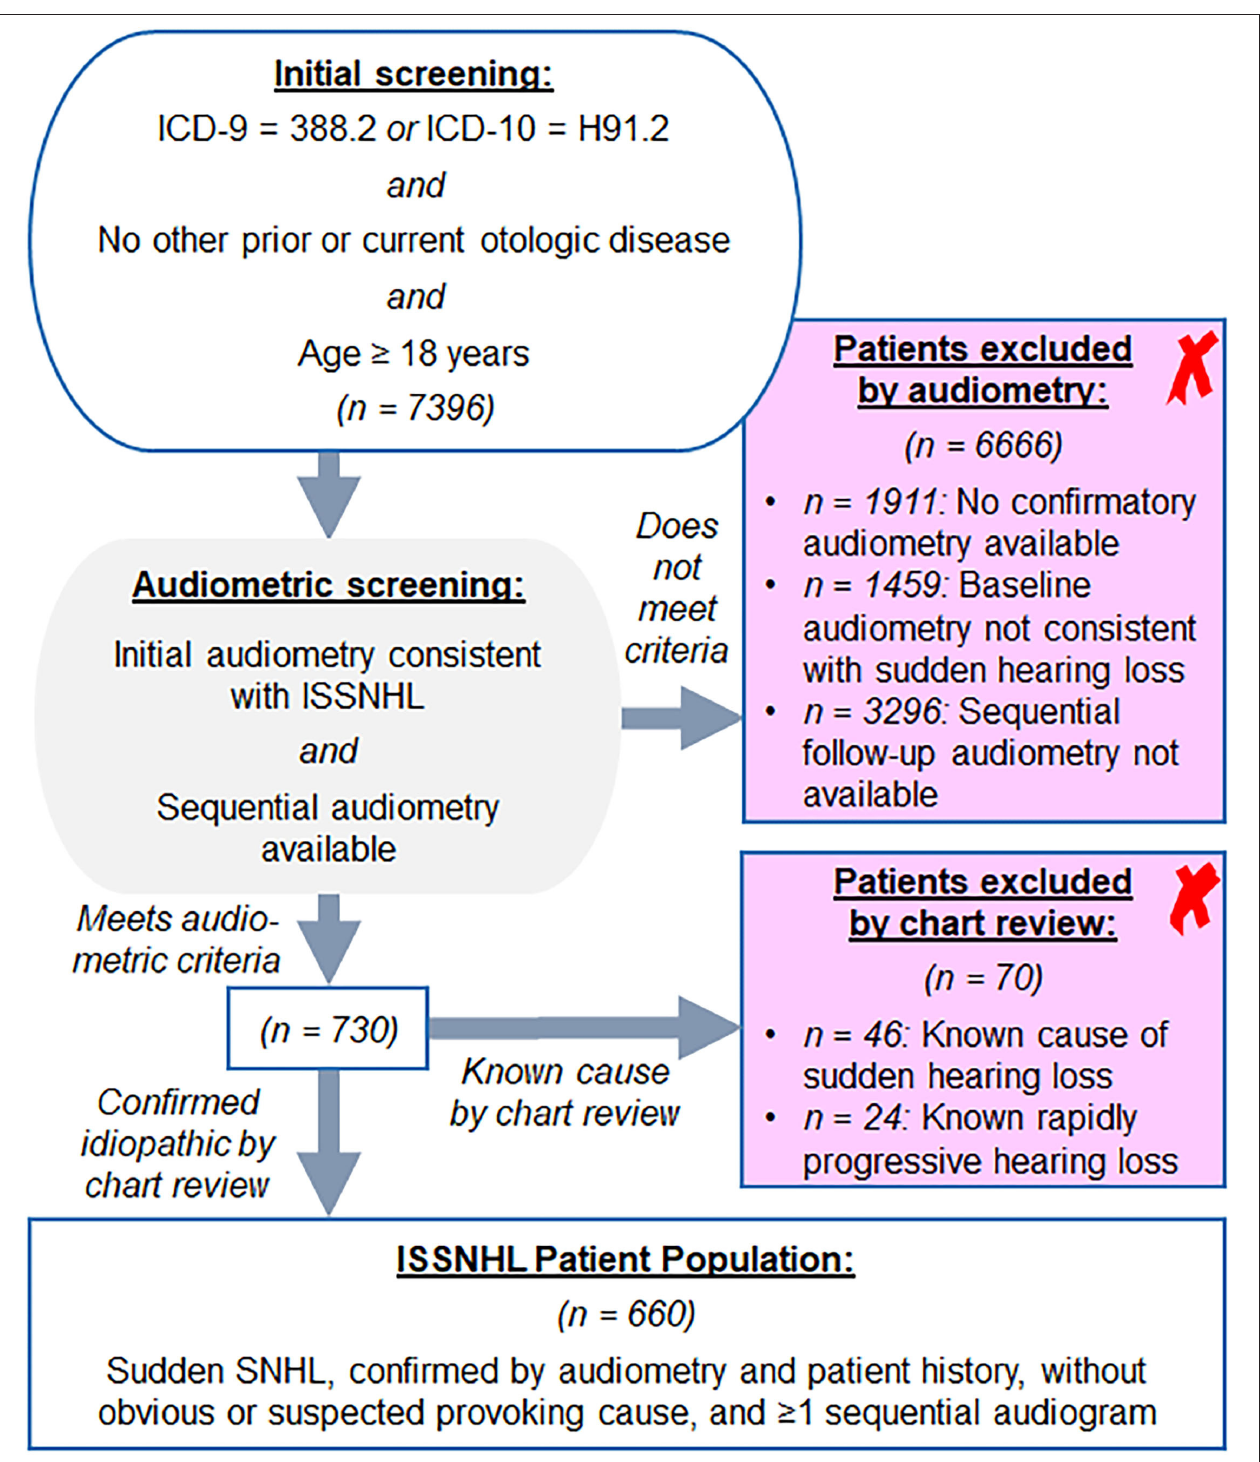
FIGURE 1 | Screening approach from Mass Eye and Ear audiology database for the patients with idiopathic sudden sensorineural hearing loss (ISSNHL) to include in study, as described in section Methods.